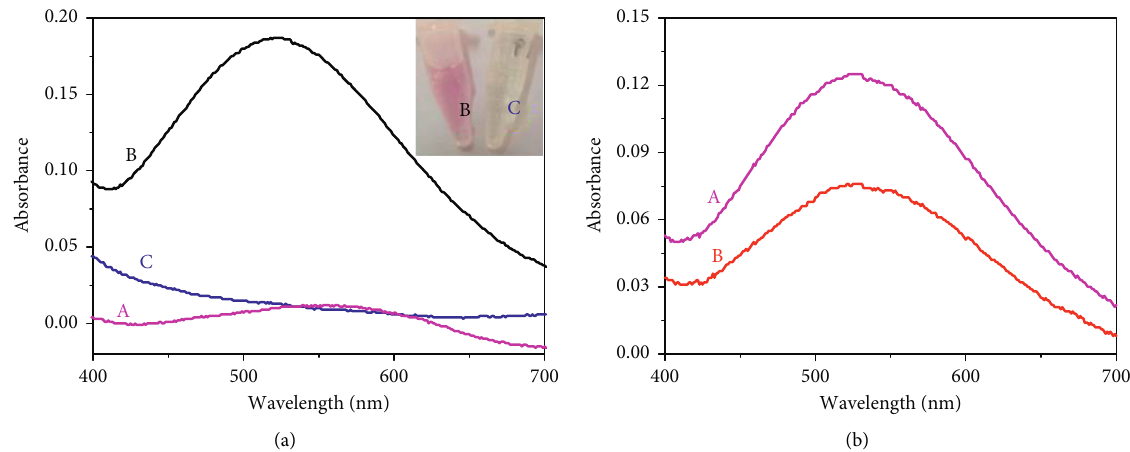
Figure 2: (a) UV-vis absorption spectra of (A) sodium salicylate (6mg/mL), (B) g-C 3 N 4 @Fe 3 O 4 +HCl+sodium salicylate, and (C) g-C 3 N 4 @ Fe 3 O 4 +HCl+sodium salicylate+EDTA in 400nm–700nm (the inset: photograph of b and c); and (b) UV-vis absorption spectra of (A) Ab 1 / CEA/Ab 2 -g-C 3 N 4 @Fe 3 O 4 and (B) Ab 1 /CEA/Ab 2 -Fe 3 O 4 for 1ng/mL CEA in phosphate buffer solution (pH